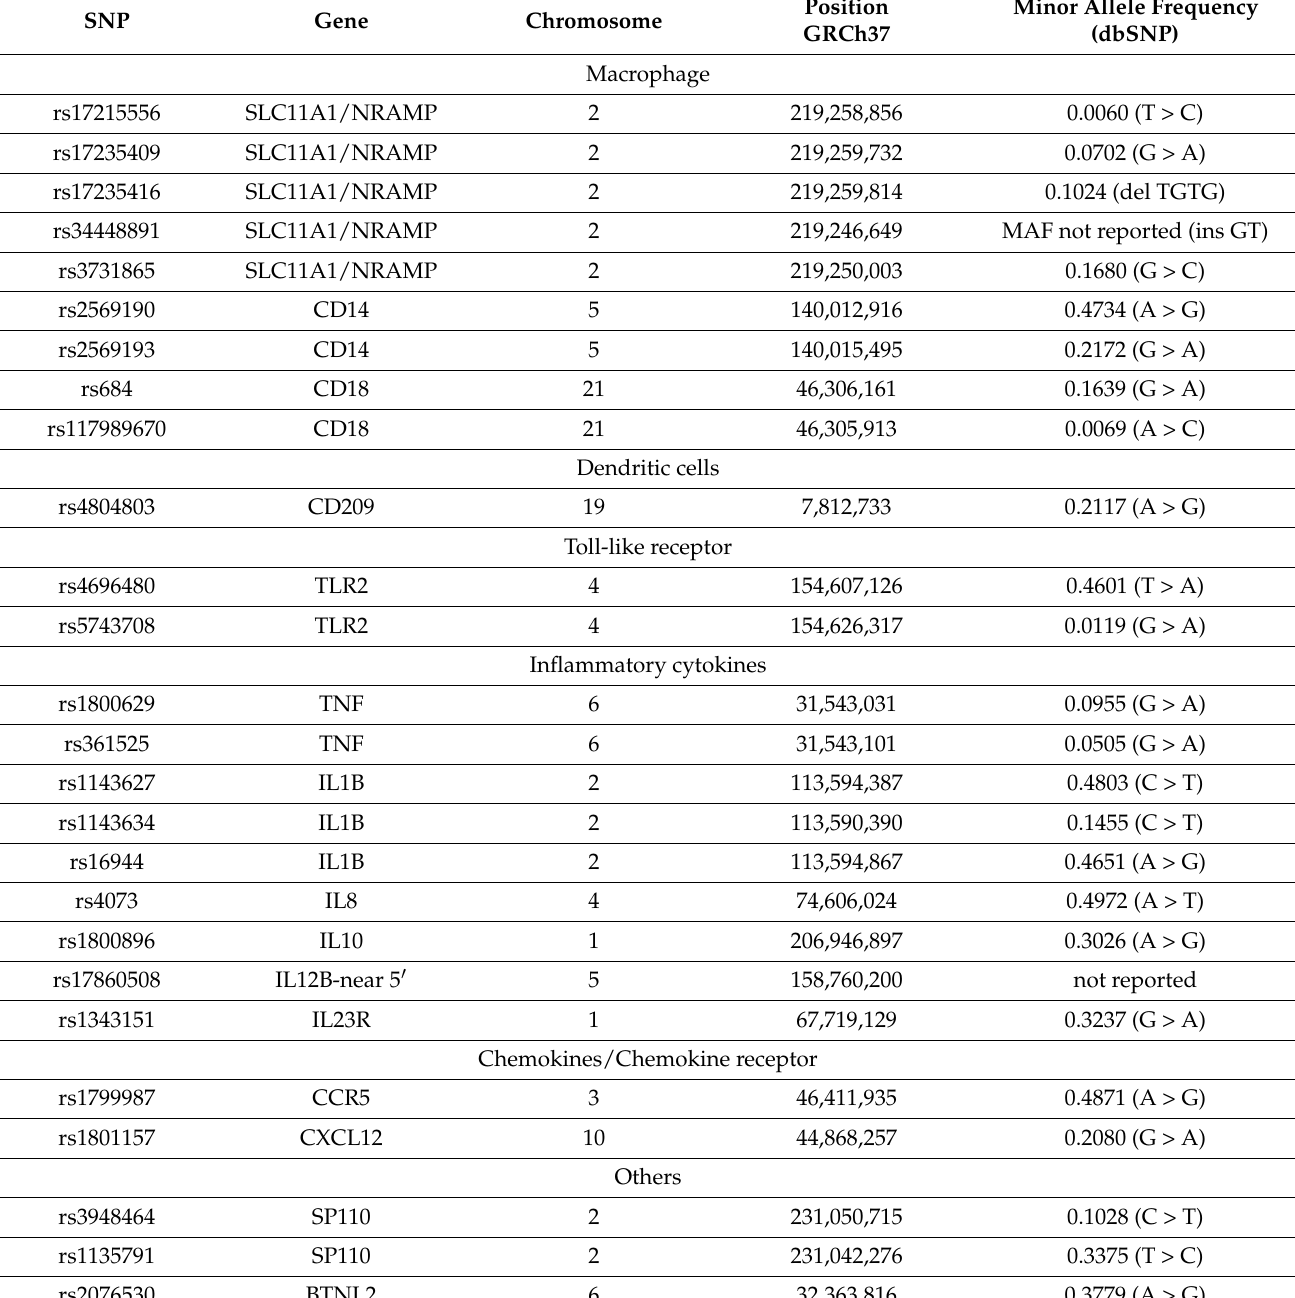
Table 1. Genomic biomarker panel of 26 SNPs and their allelic